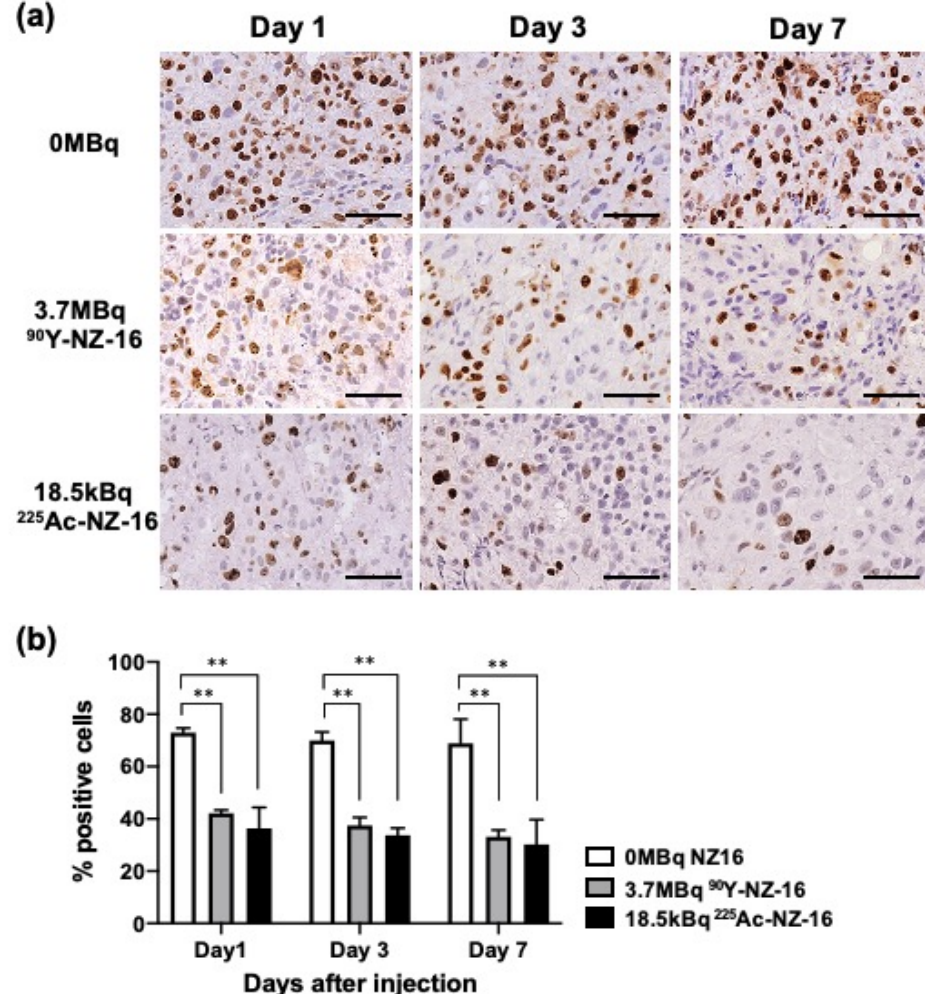
Figure 5. Tumor cell proliferation analysis using Ki-67 immunostaining. ( a ) Ki-67-stained H226 tumors at days 1, 3, and 7 after injection with 0 MBq (intact NZ-16 only), 3.7 MBq of 90 Y-labeled NZ-16, and 18.5 MBq 225 Ac-labeled NZ-16. Bar, 50 μ m ( b ) Quantification of proliferating (Ki-67 positive) cells (N = 3/group). Data represent the mean and standard deviation. ** p < 0.01. is a figure. Schemes follow the same formatting.